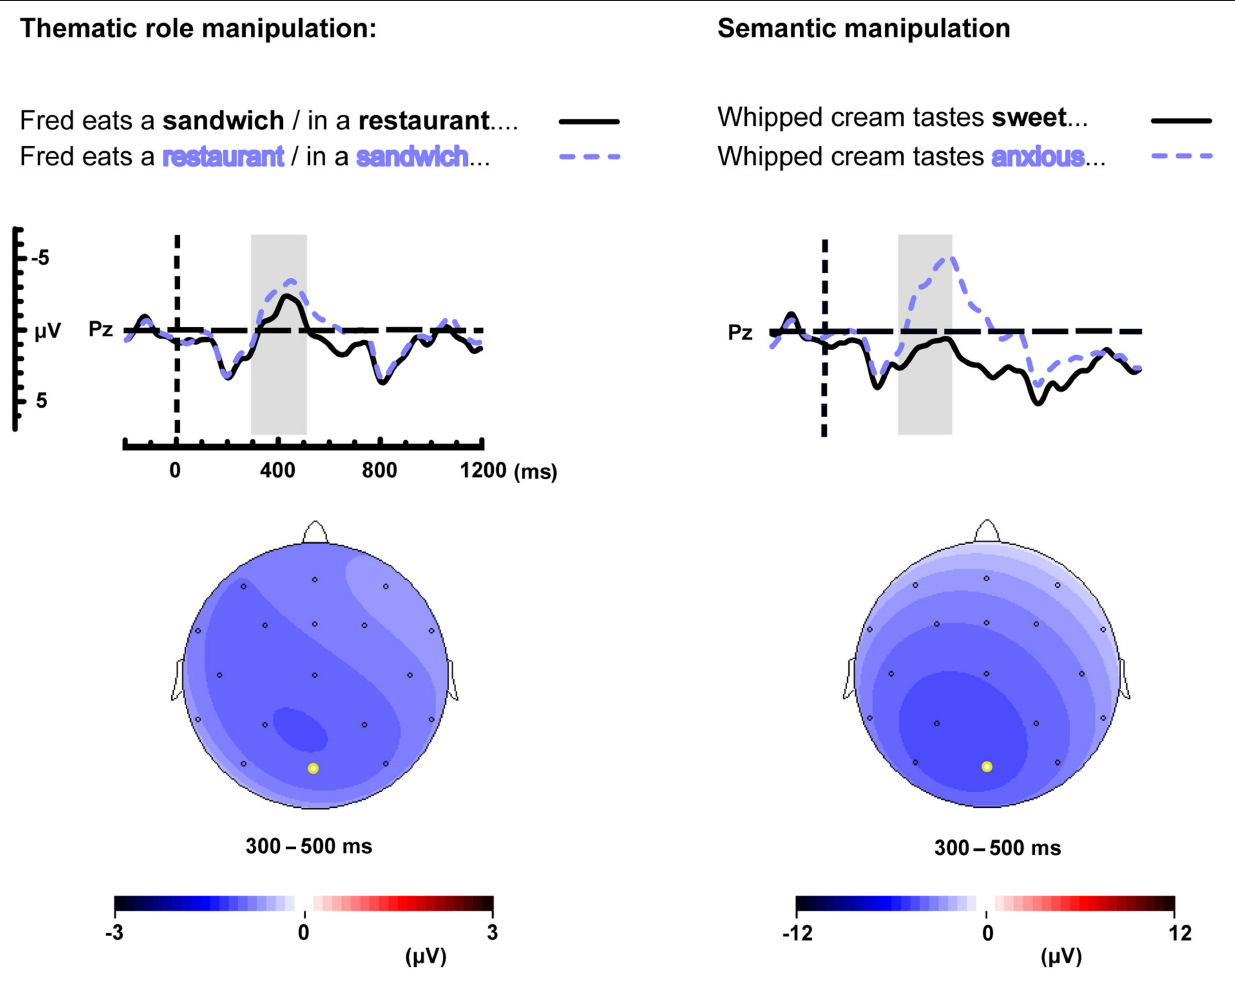
FiguRE 3 | Comparison of the effect of the thematic role and semantic manipulation: the grand-average waveforms at electrode Pz and the scalp topography with adjusted